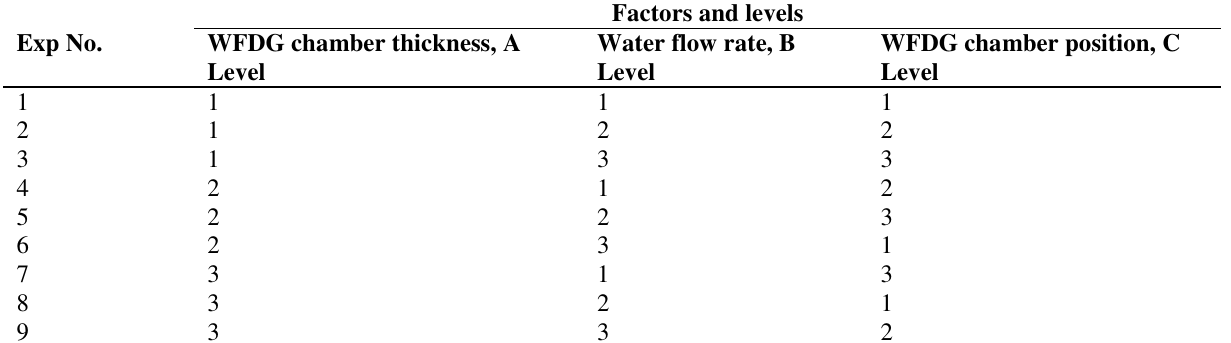
Numbering of experiments using L 9 orthogonal array.